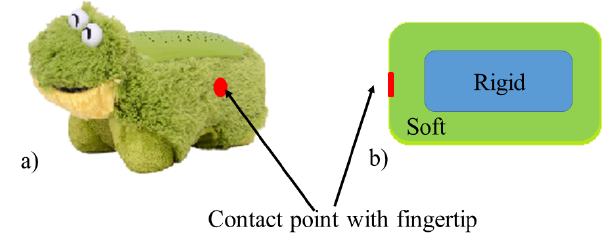
Figure 12. Photo and schematic representation of a toy object that acts as a benchmark to evaluate the performance of the integrated tactile array.